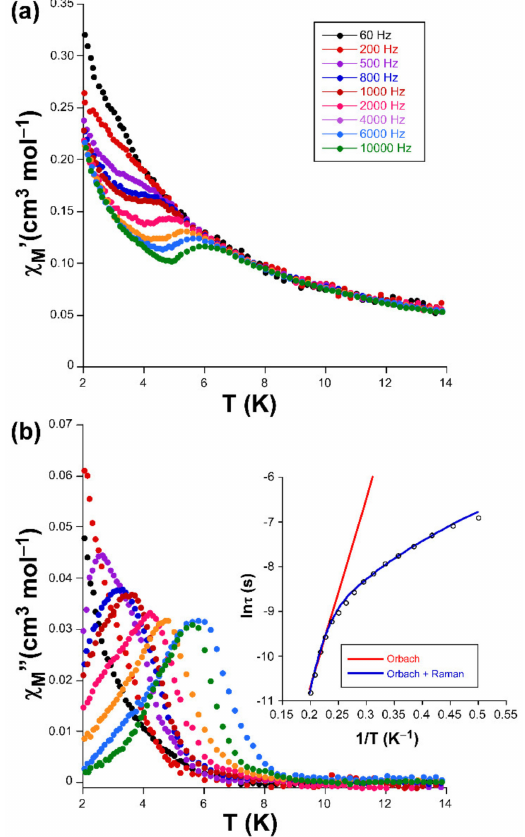
Figure 3. Temperature dependence of the ( a ) χ M ’ and ( b ) χ M ” signals for compound 1 together with the Arrhenius plot of the relaxation times.